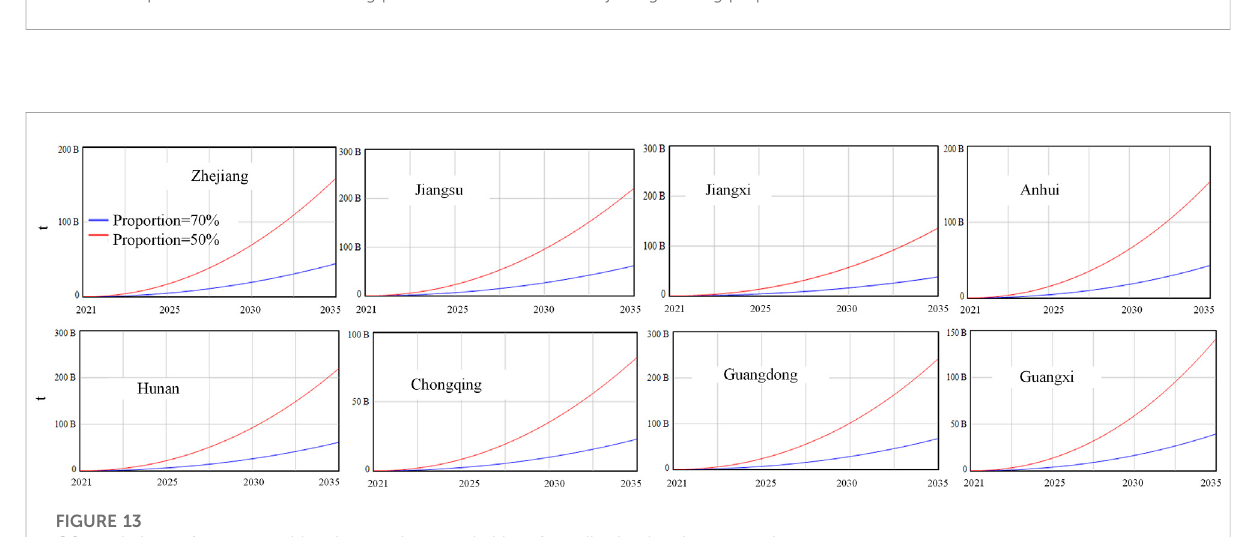
FIGURE 13 CO 2 emissions of non-central heating provinces and cities after adjusting heating